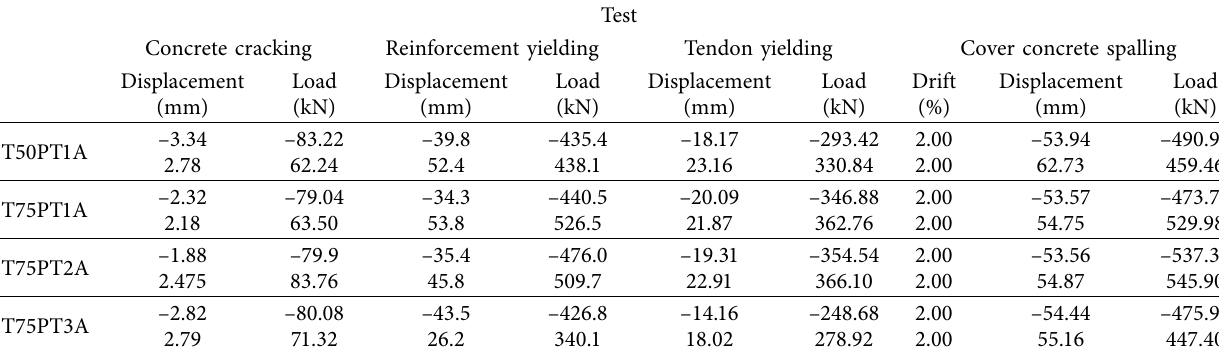
Table 6: Test result based on the proposed seismic evaluation criteria.